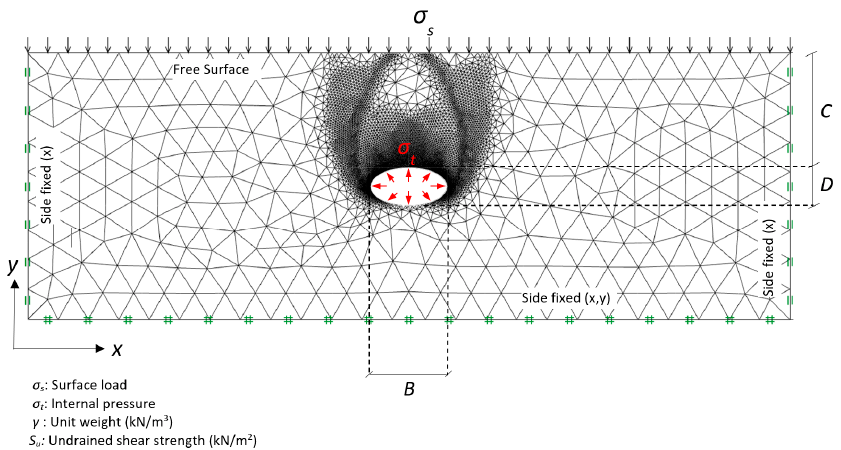
Figure 2. Problem definition and FELA mesh ( B/D = 2).